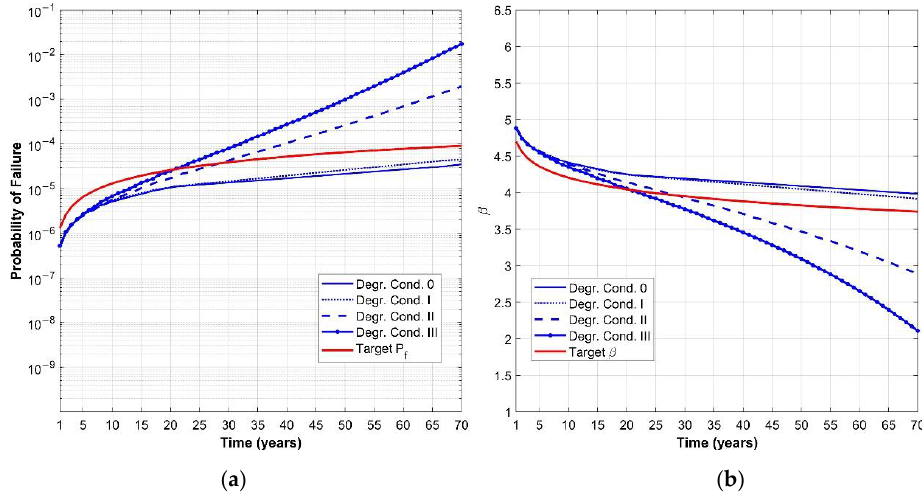
Figure 6. Time-dependent probability of failure ( a ) and reliability index 𝛽 ( b ) for residential buildings—reinforcing steel class 1 and concrete class 3 for different steel degradation conditions.